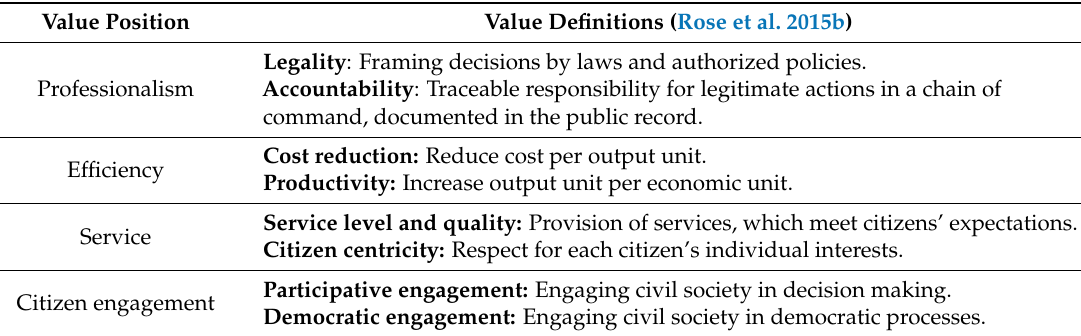
Table 2. Values and definitions.